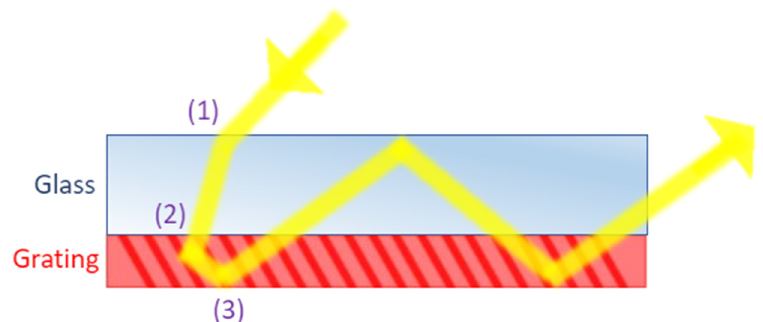
Figure 3. Principle of operation of a HOE coupler: (1) an incident light beam enters the glass layer and is refracted; (2) the beam then enters the refractive-index-matched diffraction grating and is diffracted by the grating at an angle greater than the critical angle for the medium; (3) the beam is totally internally reflected and ‘coupled’ along the length of the device.